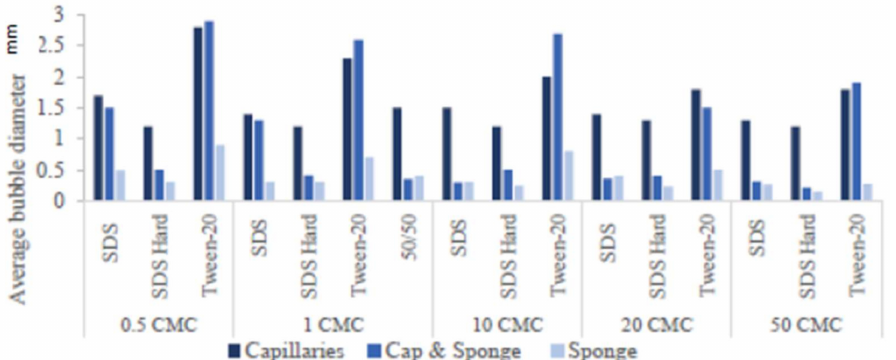
Figure 6. Comparison of average bubble diameter under different conditions at concentrations: 0.5, 1, 10, 20, and 50 critical micelle concentration (CMC).